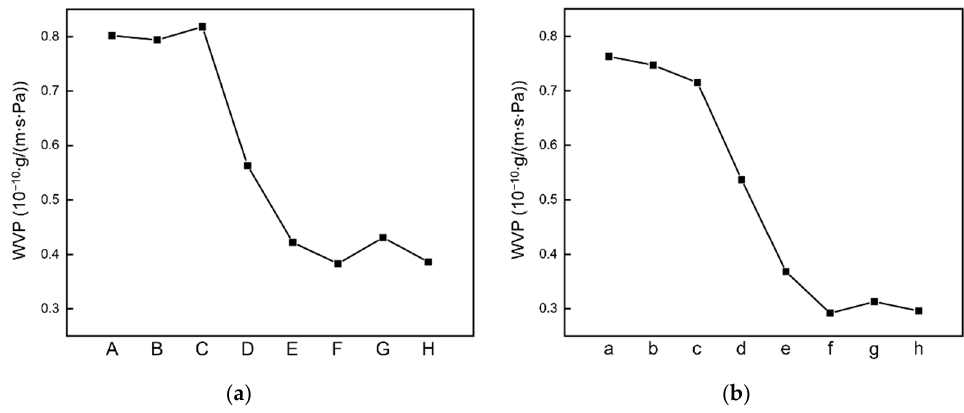
Figure 14. Water vapor permeabilities of the sandwich-structured PVA-based ( a ) PEG–PLA(70) and PEG–PLA(70) + neat PLA, and ( b ) PEG–PLA(140) and PEG–PLA(140) + neat PLA hydrophobic composite films. The temperatures, durations, and notations corresponding to this heat treatment are listed in Table 2.